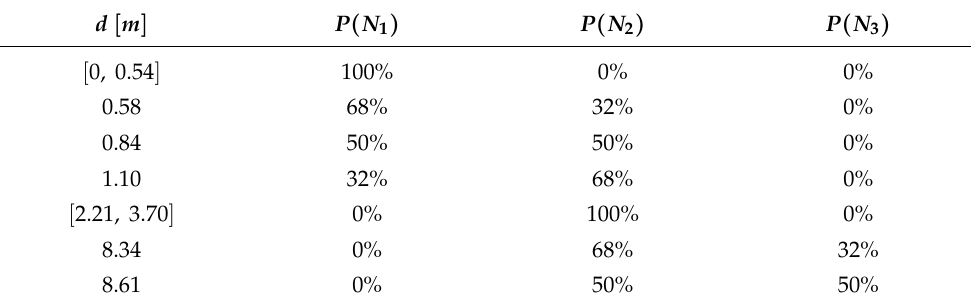
Table 12. Probability of finding layer N i at depth d